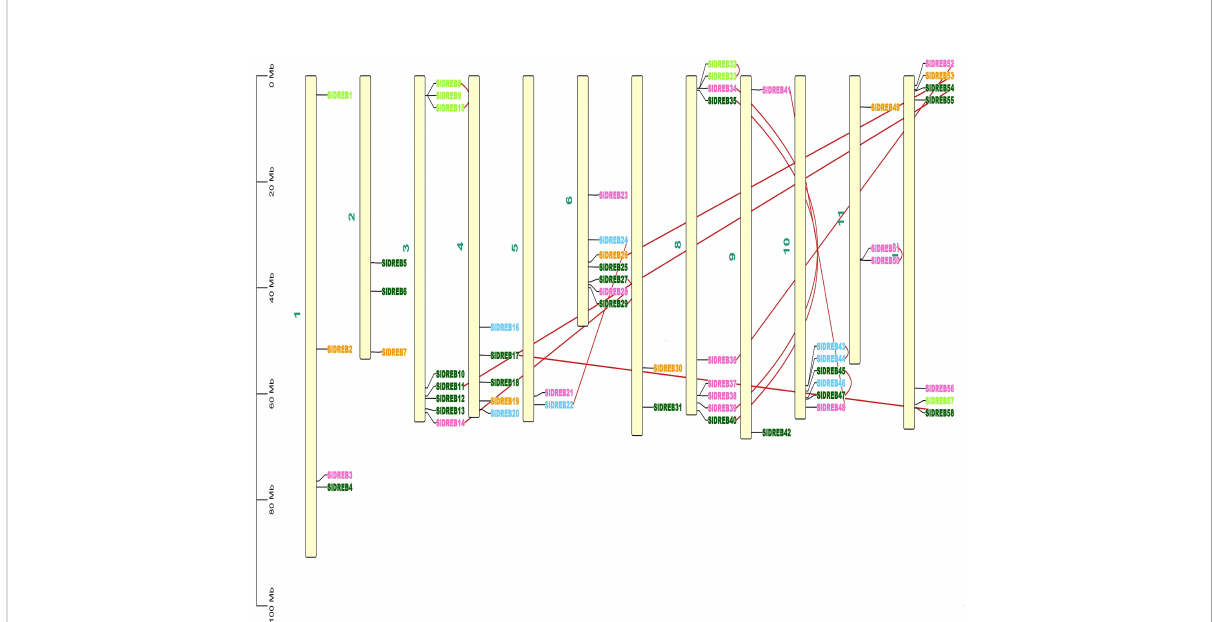
FIGURE 4 Chromosomal distribution of 58 SlDREB genes within the genome was illustrated by using TBtools. Each color of the SlDREB genes represents its class according to the phylogenetic tree. The scale shows the length of each chromosome. Red lines that linked the gene pairs present on the same chromosome denoted tandem duplication